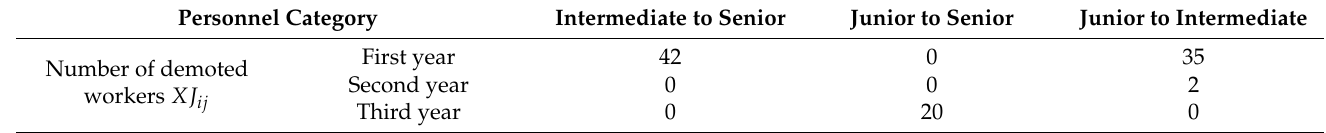
Table 9. Number of demoted workers in the past three years.